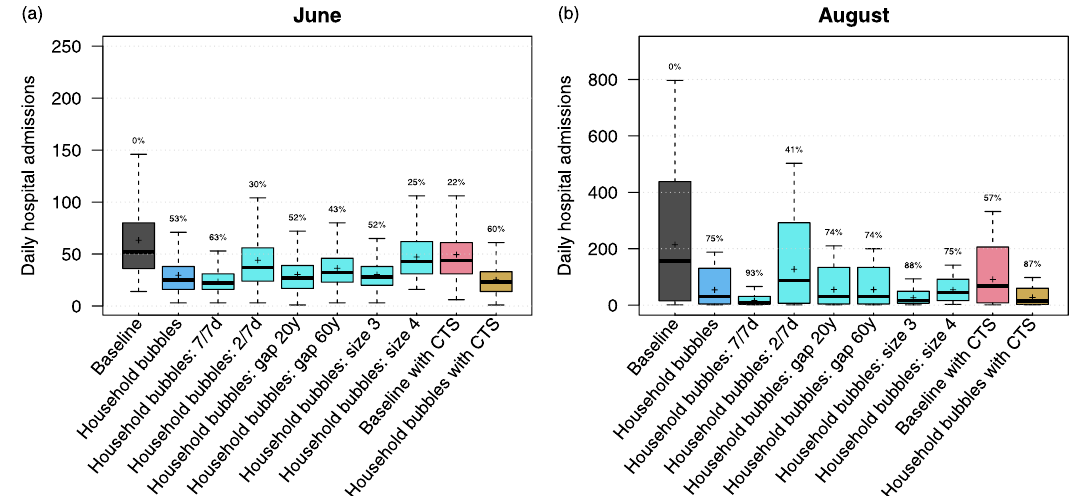
Fig. 3 Daily hospital admissions per scenario. Distribution of the daily hospital admissions by June ( a ) and August ( b ) per scenario. The results are presented as the median (line), quartiles (box), 2.5 and 97.5 percentiles (whiskers) and average (cross) of 40 model realisations (i.e., ten stochastic runs for each of the four social contact behaviour assumptions). The percentage on top of the whiskers indicates relative reduction of the scenario average with respect to the baseline. CTS contact tracing strategy.